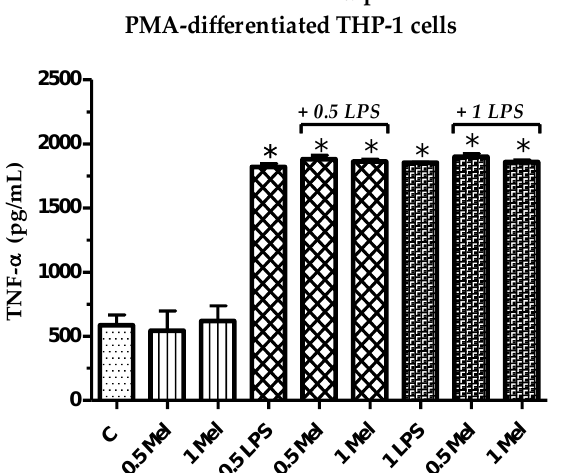
Figure 2. Effect of melittin on the production of tumour necrosis factor- α (TNF- α ) cytokines in the presence and absence of LPS on PMA-differentiated THP-1 cells. All six treatments were significantly different from the negative control ( n = 3). C: control; Mel: melittin; LPS: lipopolysaccharides; *: Significant ( p < 0.05).